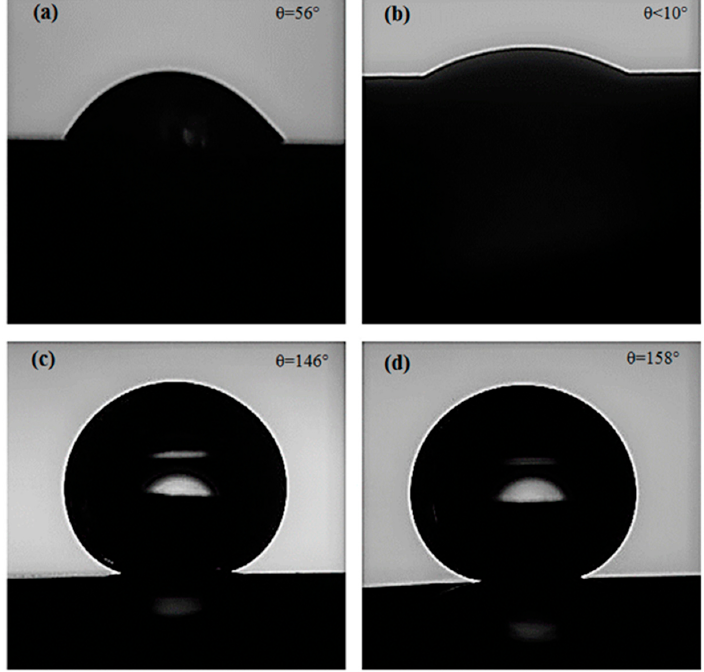
Figure 3. Water droplets during contact-angle measurement on ( a ) D12, ( b ) D25, ( c ) functionalized D12, and ( d ) functionalized D25.